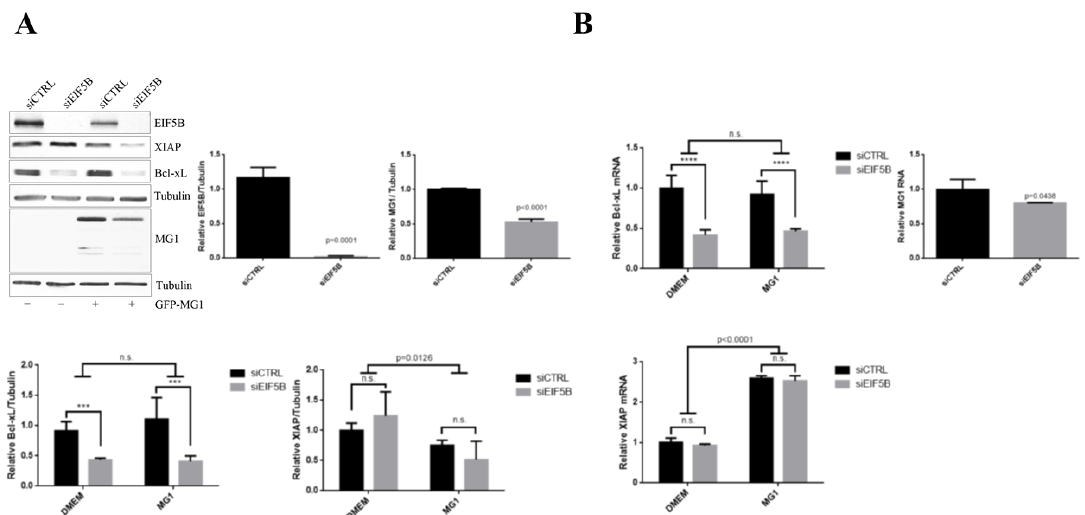
Figure 6. eIF5B knock-down negatively regulates the expression of Bcl-xL and MG1. ( A ) U2OS cells were transfected with eIF5B-targeting or non-targeting control siRNAs followed by 12 h of mock- or infection with MG1 at MOI = 0.1. Western blot demonstrates the level of eIF5B, Bcl-xL, XIAP, MG1 and Tubulin (loading control) proteins. The expressions of Bcl-xL and XIAP proteins were quantified relative to Tubulin by densitometry (*** p = 0.0009; ns, non-significant). ( B ) Steady-state levels of Bcl-xL , XIAP mRNA and MG1 genomic RNA were measured by RT-qPCR in siCTRL or siEIF5B transfected cells after 12 hpi with MG1 or DMEM treatment. Ct values were normalized by the standard curve method and represented relative to the geometric mean of RPL13 A and RPL36A (**** p < 0.0001; ns, non-significant).